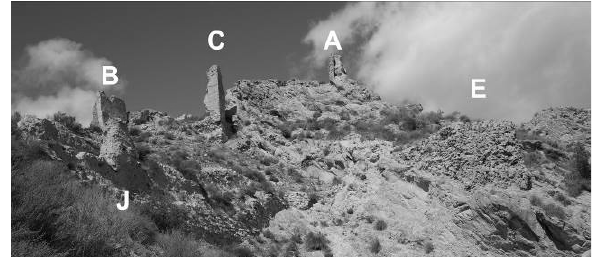
Figure 4. View of the east elevation and the upper enclosure.